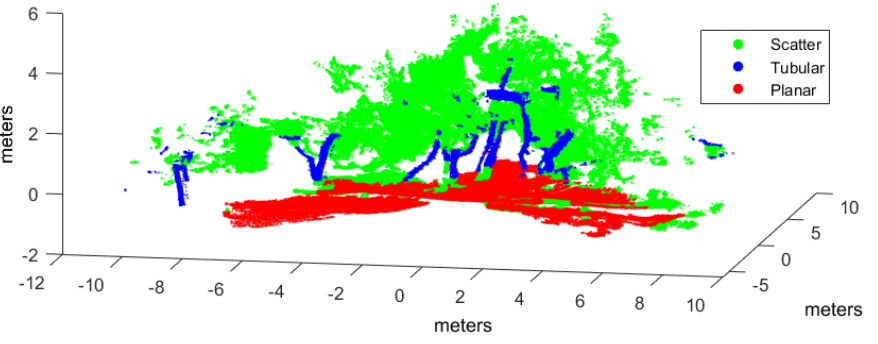
Figure 3. Hand labeled Natural_1 point